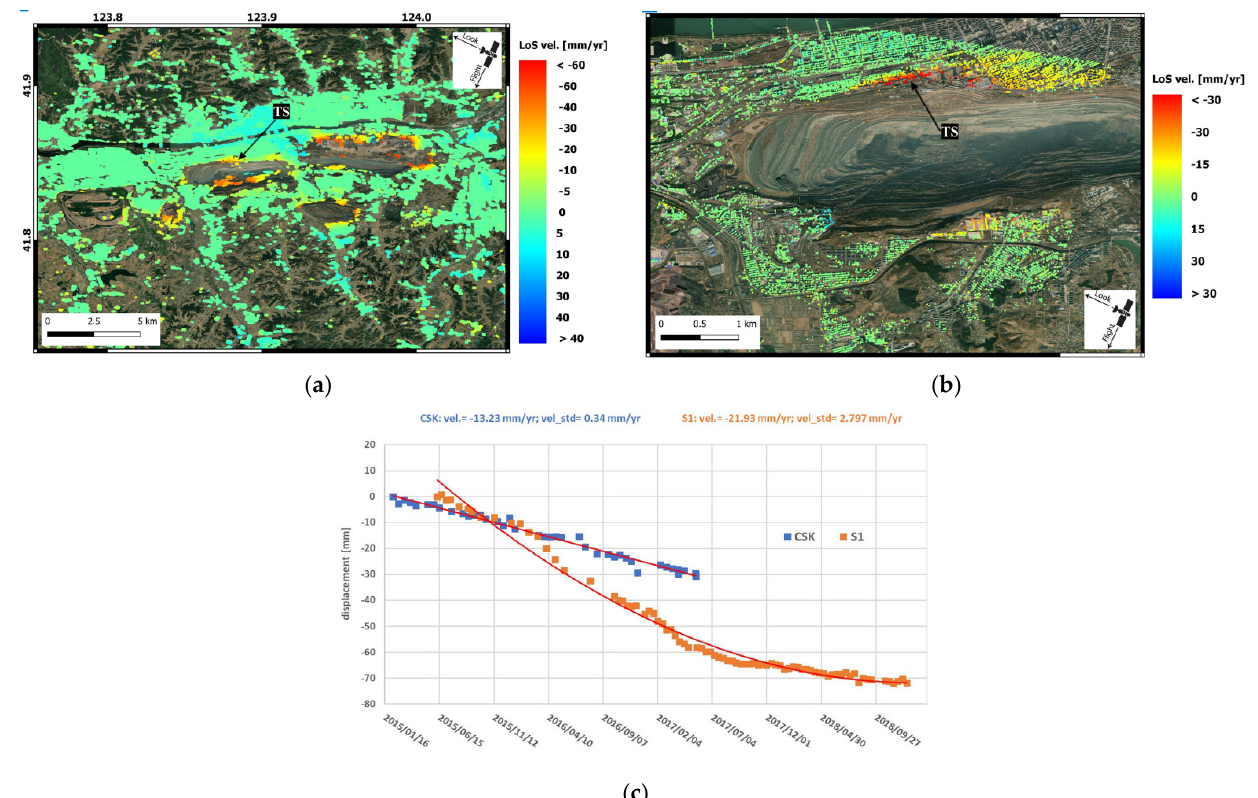
Figure 11. Ground velocity maps for the Fushun pit mine area. ( a ) S1 ground descending velocity map; ( b ) CSK ground descending velocity map; ( c ) displacement time series for the Persistent Scaterrer (PS), marked as TS in (a) and (b), measured by COSMO–SkyMed data (blue symbols), and S1 (orange symbols).